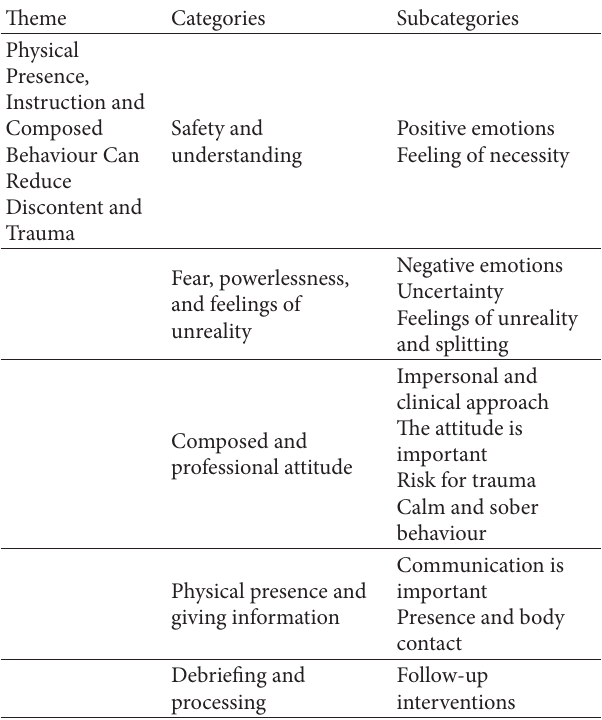
Table 1: Theme and